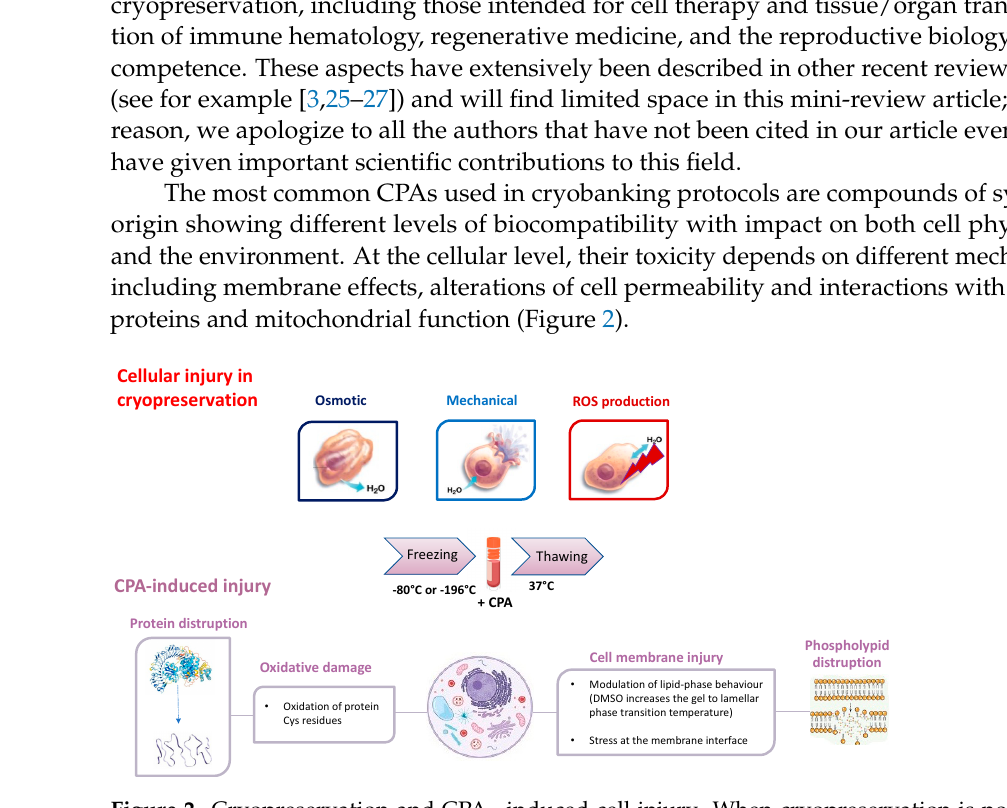
Figure 2. Cryopreservation and CPA − induced cell injury. When cryopreservation is not carried out